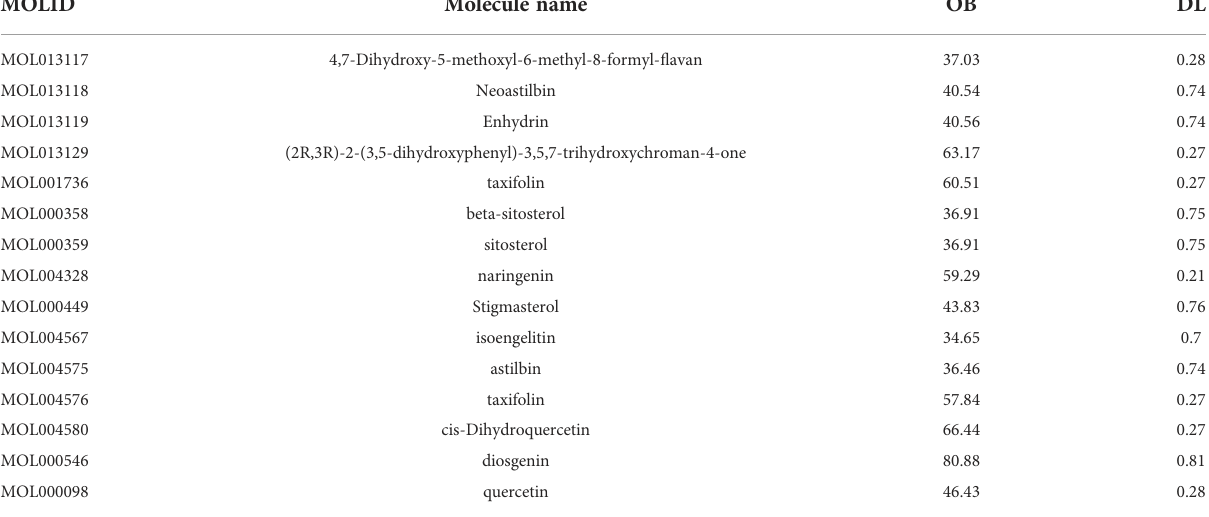
TABLE 2 Core components of baituling.